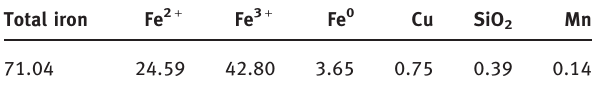
Table 1: Chemical analysis of mill scale (wt.%). Total iron